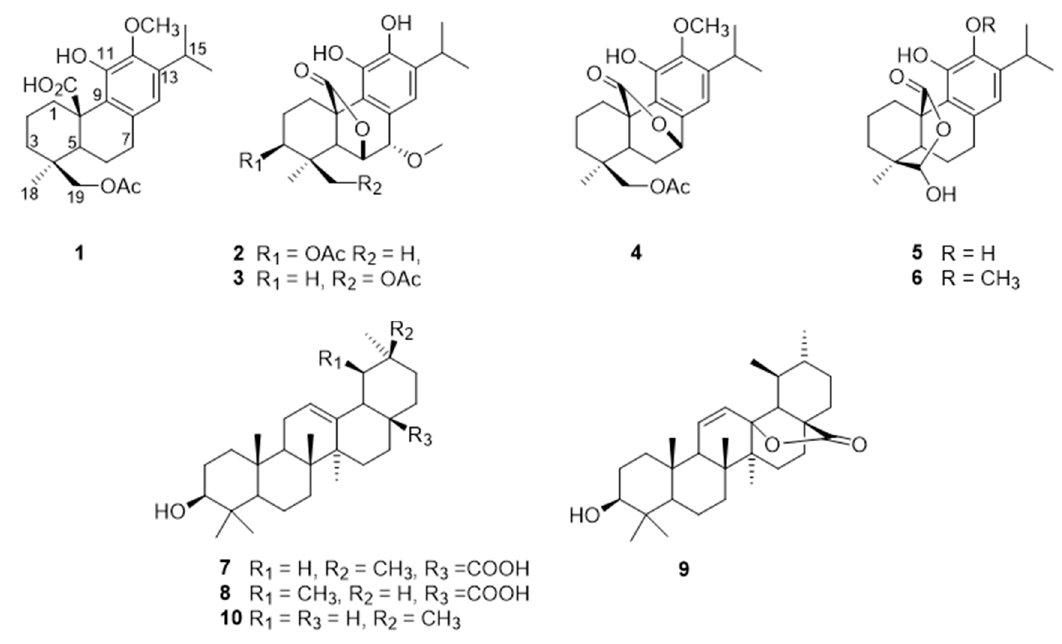
Figure 1. Chemical structures of the isolated compounds ( 1 – 10 ) from S. africana-lutea.